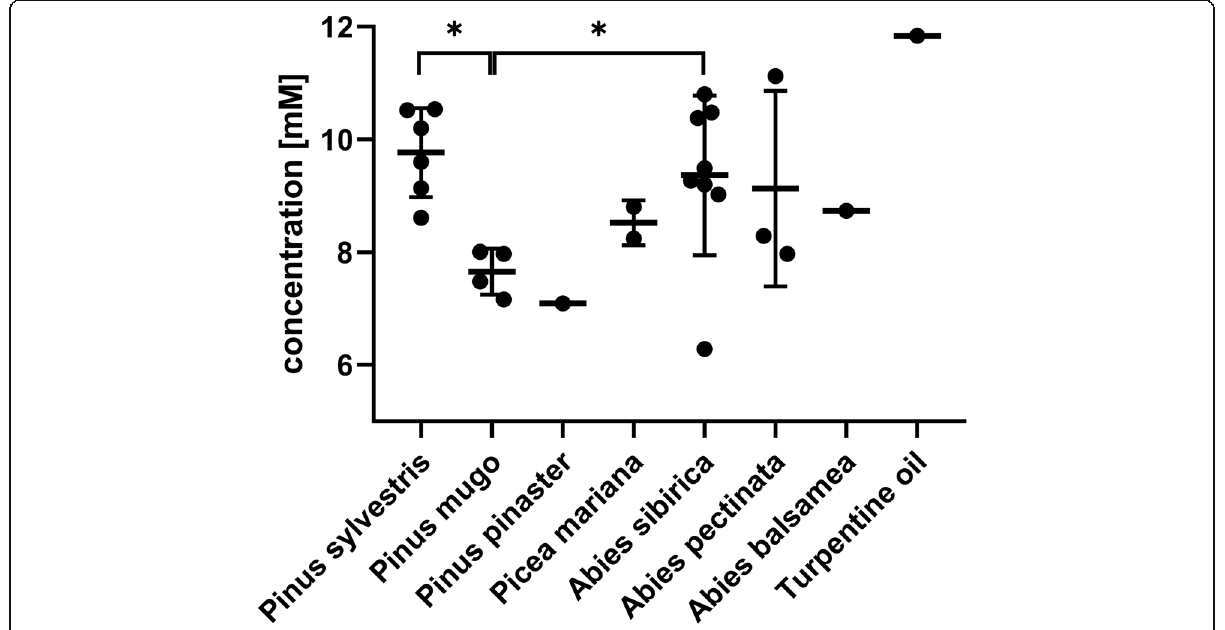
Fig. 4 Total terpene amount of the analyzed CEOs. Significance was tested using an unpaired t-test with p < 0.05